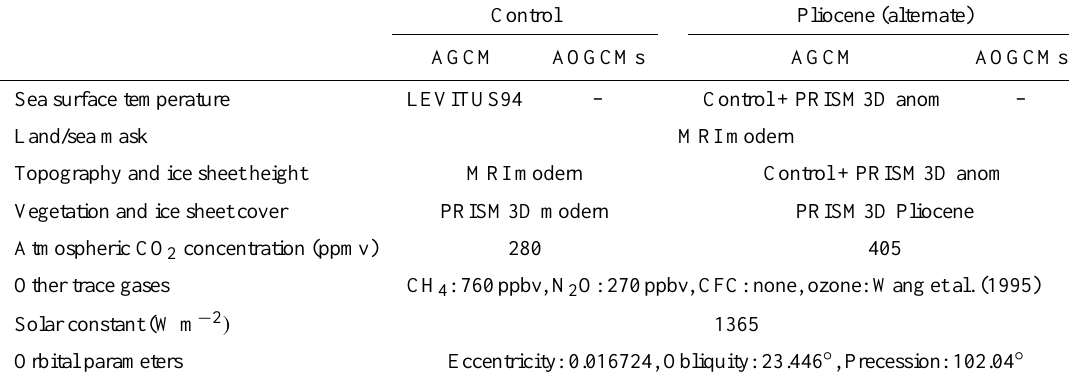
Table 1. Summary of boundary conditions and external forcings prescribed in the experiments.